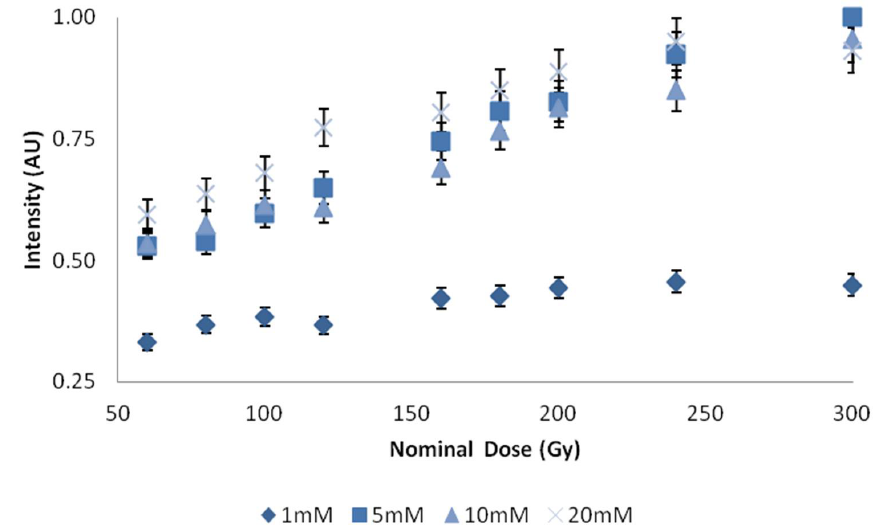
Figure 4. Dose plotted against intensity for concentrations of C3CA in 7% gelatin. X -axis represents central axis dose for the depth of cuvette, Y -axis, represents an arbitrary unit of light intensity. Error bars represent a 5% variation from the mean; calculated standard deviation from n = 4 samples per data point, less than 1%.